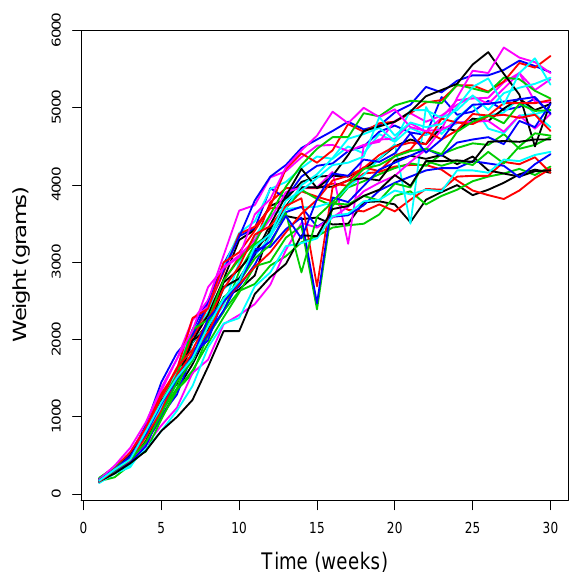
Figure 1. Weight of 29 rabbits over 30 weeks.